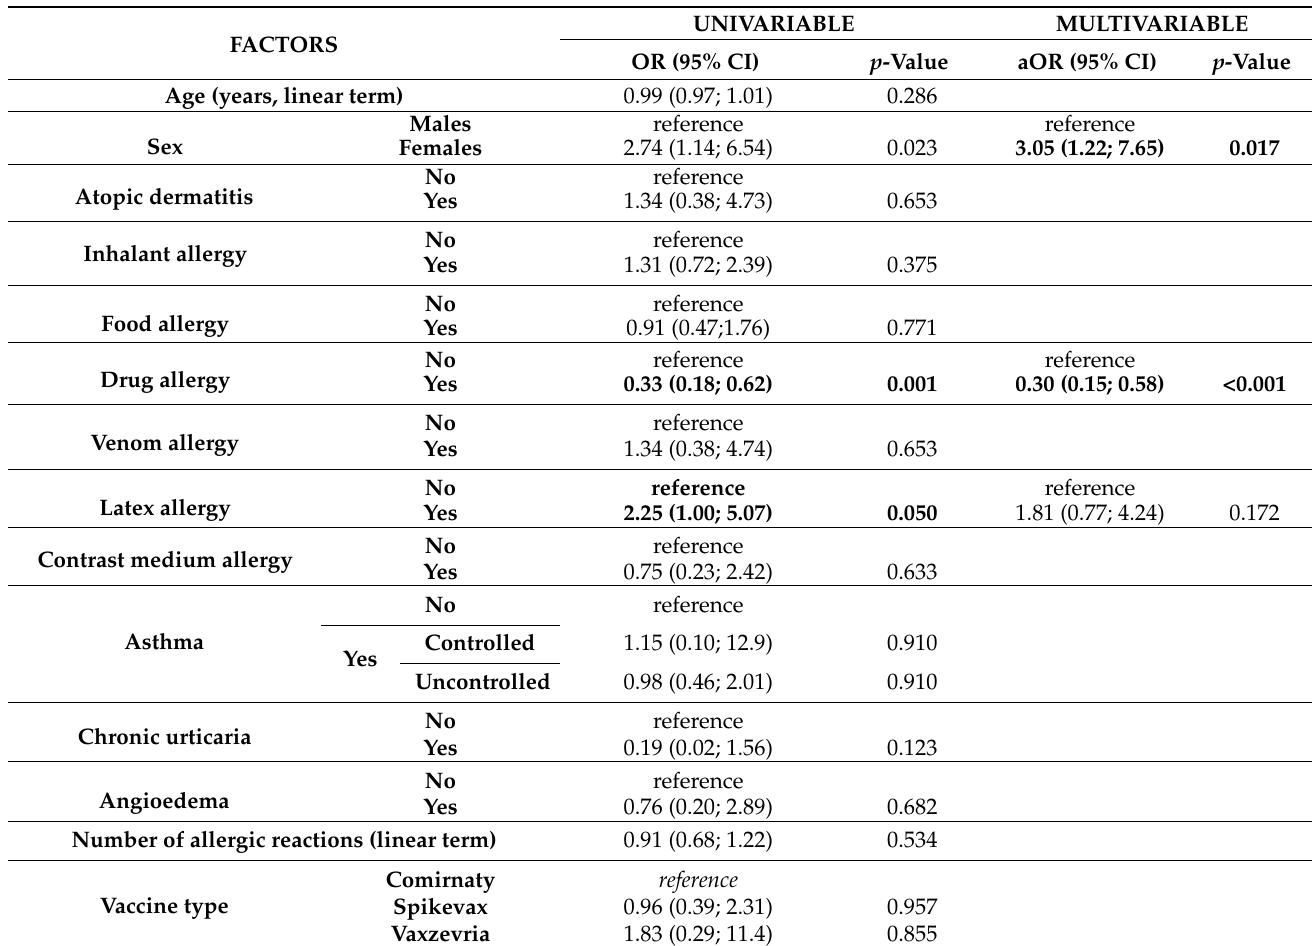
Table 2. Univariable and multivariable logistic regression analysis on risk factors for allergic reactions following COVID-19 vaccinations. Odds ratios unadjusted (ORs) and adjusted (aORs) with 95% confidence intervals (95%